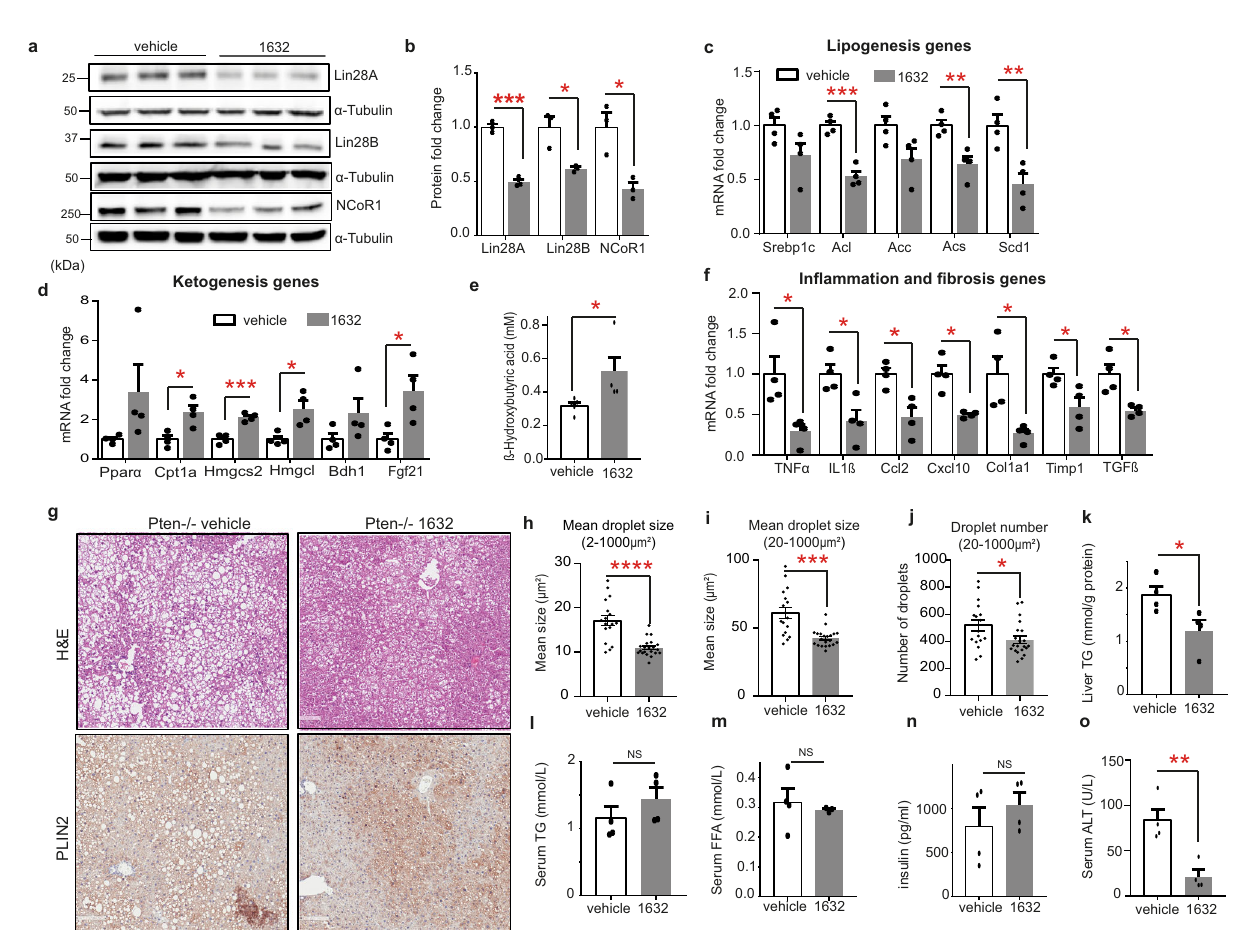
Fig. 5 | C1632 attenuates hepatosteatosis in a genetic mouse model of NAFLD. a, b Representative immunoblot analysis and quantitative densitometric analysesfor Lin28A, Lin28B and NCoR1 inliversfrom 28-week-old Pten -/- malemice treatedwithvehicleorC1632(50mg/kg)after6weeksoftreatment(3IPinjections per week). α -Tubulin was used as a loading control (n =3 mice/group; Lin28A *** P =0.0002;Lin28B,* P =0.0183;NCoR1,* P =0.0172). c,d RelativemRNAlevelsof lipogenic and ketogenic genes in livers from Pten -/- male mice treated with vehicle orC1632asdescribedin( a )( n =4mice/group;Acl,*** P =0.0003;Acs,** P =0.0076; Scd1, ** P =0.0074; Cpt1a, * P =0.0181; Hmgcs2, *** P =0.0005; Hmgcl, * P =0.0280; Fgf21,*P=0.0450). β -Actinwasusedasahousekeepinggene. e Serum β -OHBlevels in Pten -/- mice treated with vehicle or C1632 as described in ( a ) ( n =4 mice/group, * P =0.0331). f Relative mRNA levels of in fl ammation and fi brosis markers in livers fromPten -/- male mice treatedwithvehicleorC1632asdescribed in ( a )( n =4mice/ group; TNF α , * P =0.0424; IL1 β , * P =0.0183; Ccl2, *P =0.0119; Cxcl10, * P =0.0157; Col1a1, * P =0.0409; Timp1 * P =0.0356, TGFb, * P =0.0298). β -Actin was used as a